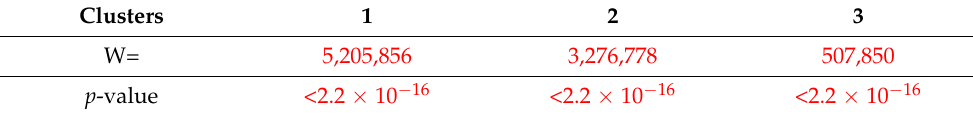
Table 15. Wilcoxon rank-sum test of the voltage unbalance factor k u2 ( α = 0.05). Clusters 1